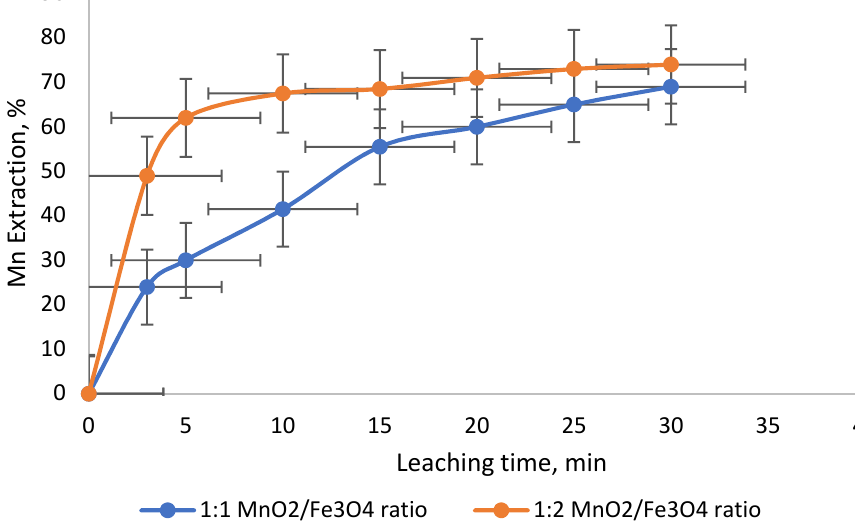
Figure 3. Manganese dissolution from marine nodule at different ratios of MnO 2 /Fe 3 O 4 and 1 mol/L H 2 SO 4 .